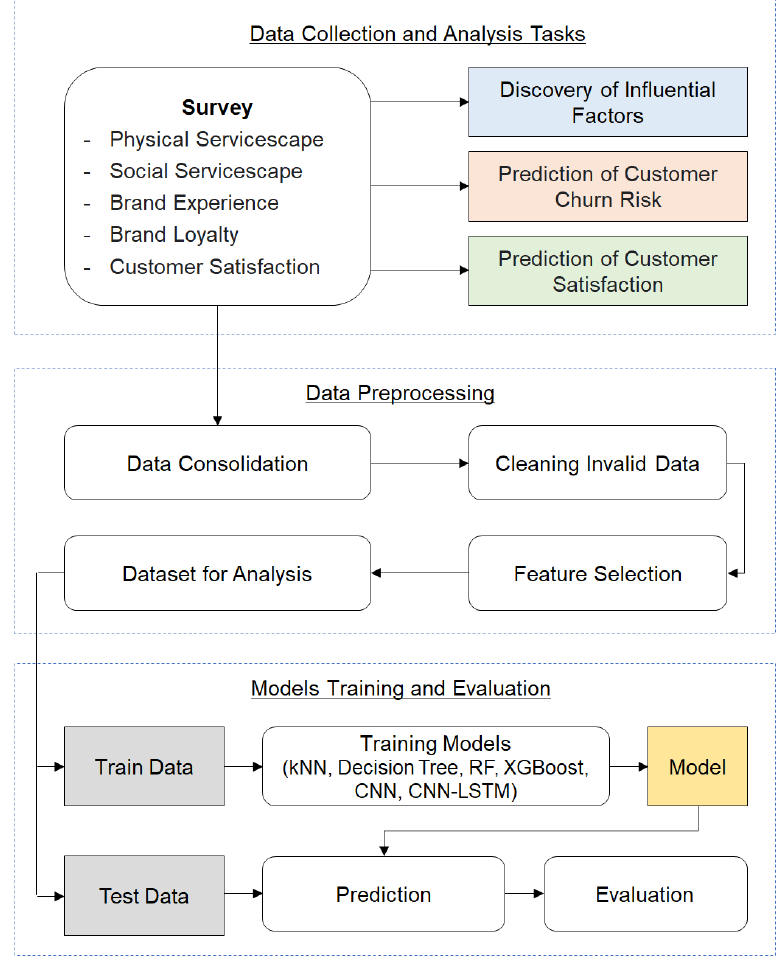
Figure 1. Overall flow of the proposed methodology.